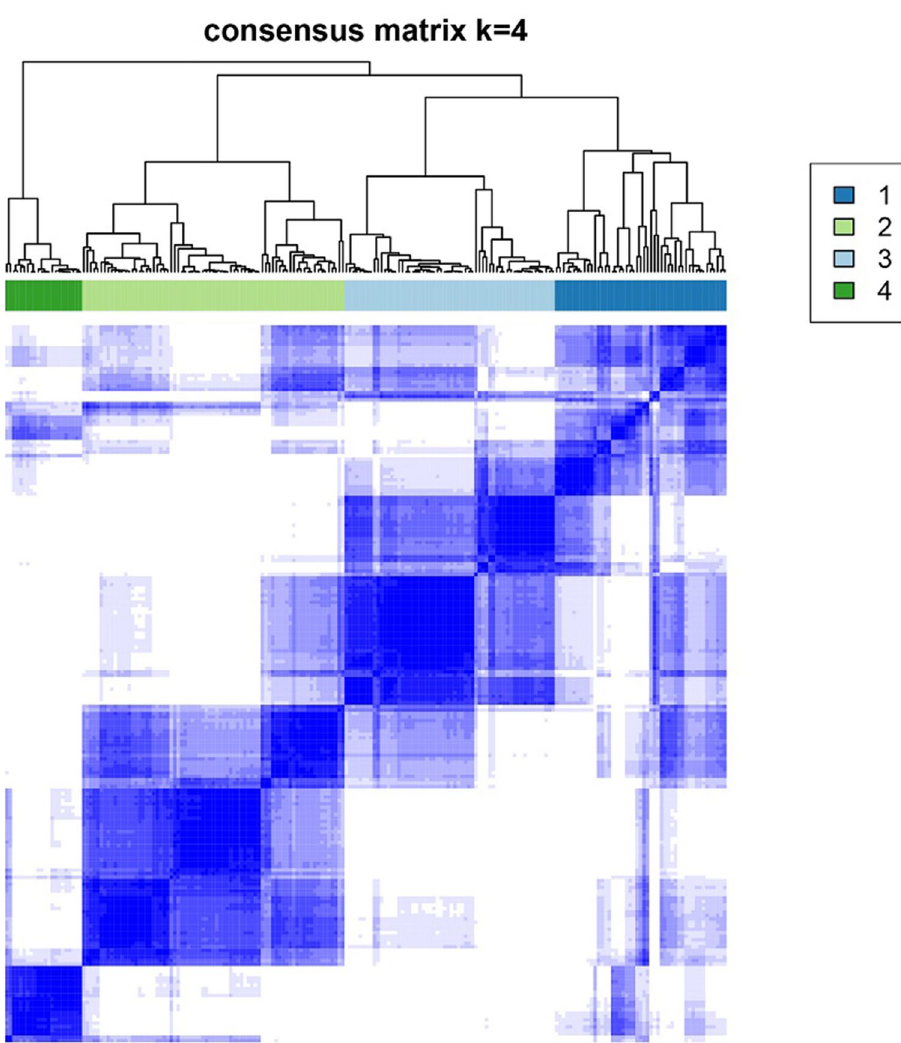
Figure 6. When k = 4, the clustering heat map of UC is made by R package ConsensusClusterPlus (https ://bioco nduct or.org/packa ges/relea se/bioc/html/Conse nsusC luste rPlus .html).